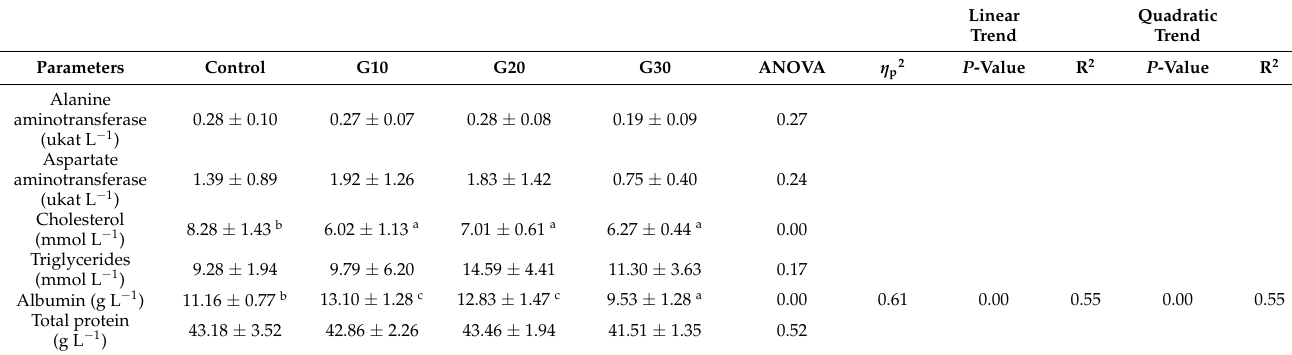
Table 6. Serum biochemistry of Eurasian perch provided feed supplemented with garlic